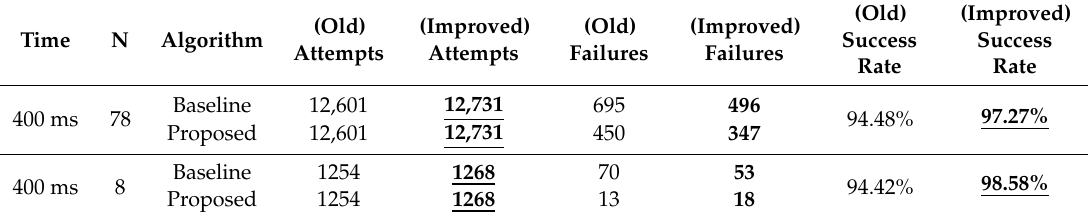
Table 13. Improvements in HSR with improved algorithms.